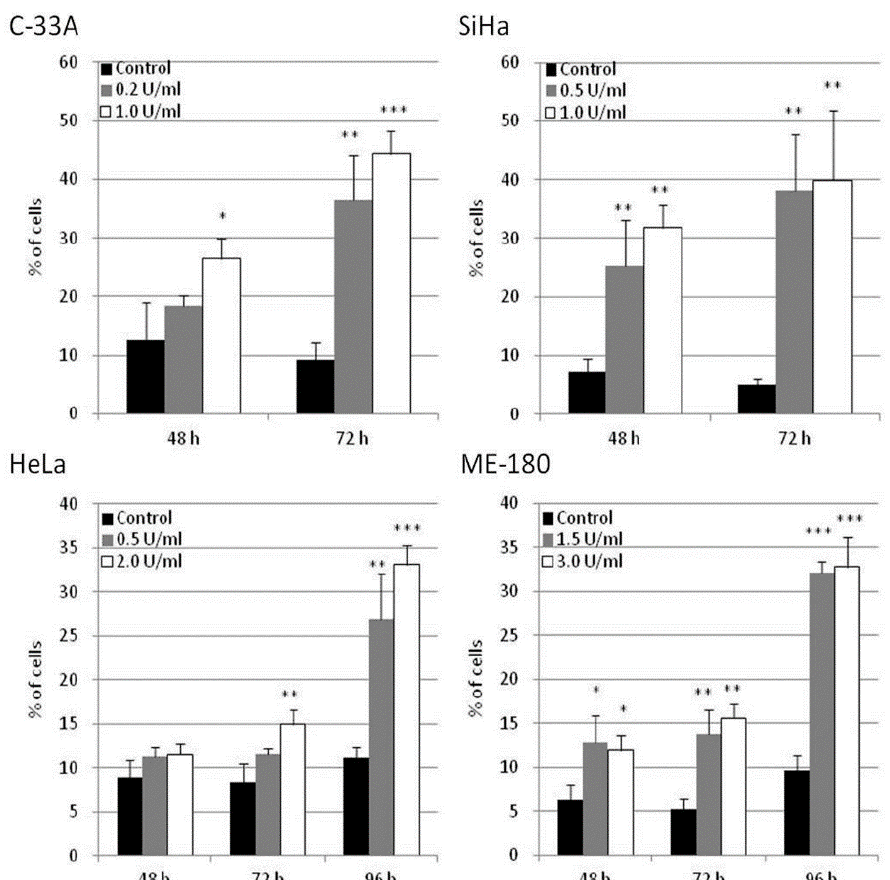
Figure 7. BCA-M-induced apoptosis in human cervical cancer cells. Apoptosis induction was detected using flow cytometric analysis with Annexin V-FITC and propidium iodide (PI) staining. The results for percentage of apoptotic cells were shown as means and S.D. One-way ANOVA with post hoc Dunnett’s test showing p values for comparison between control and treatment as: * p < 0.05, ** p < 0.01, *** p < 0.001.